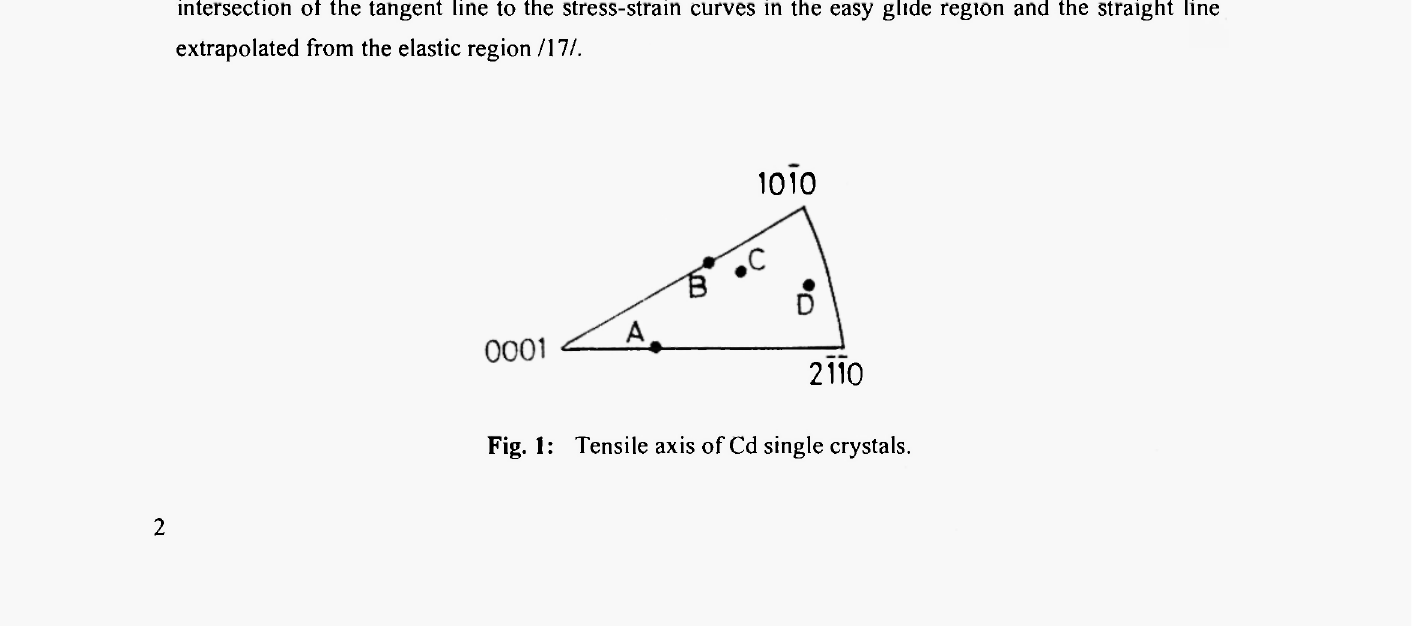
Fig. 1 : Tensile axis of Cd single